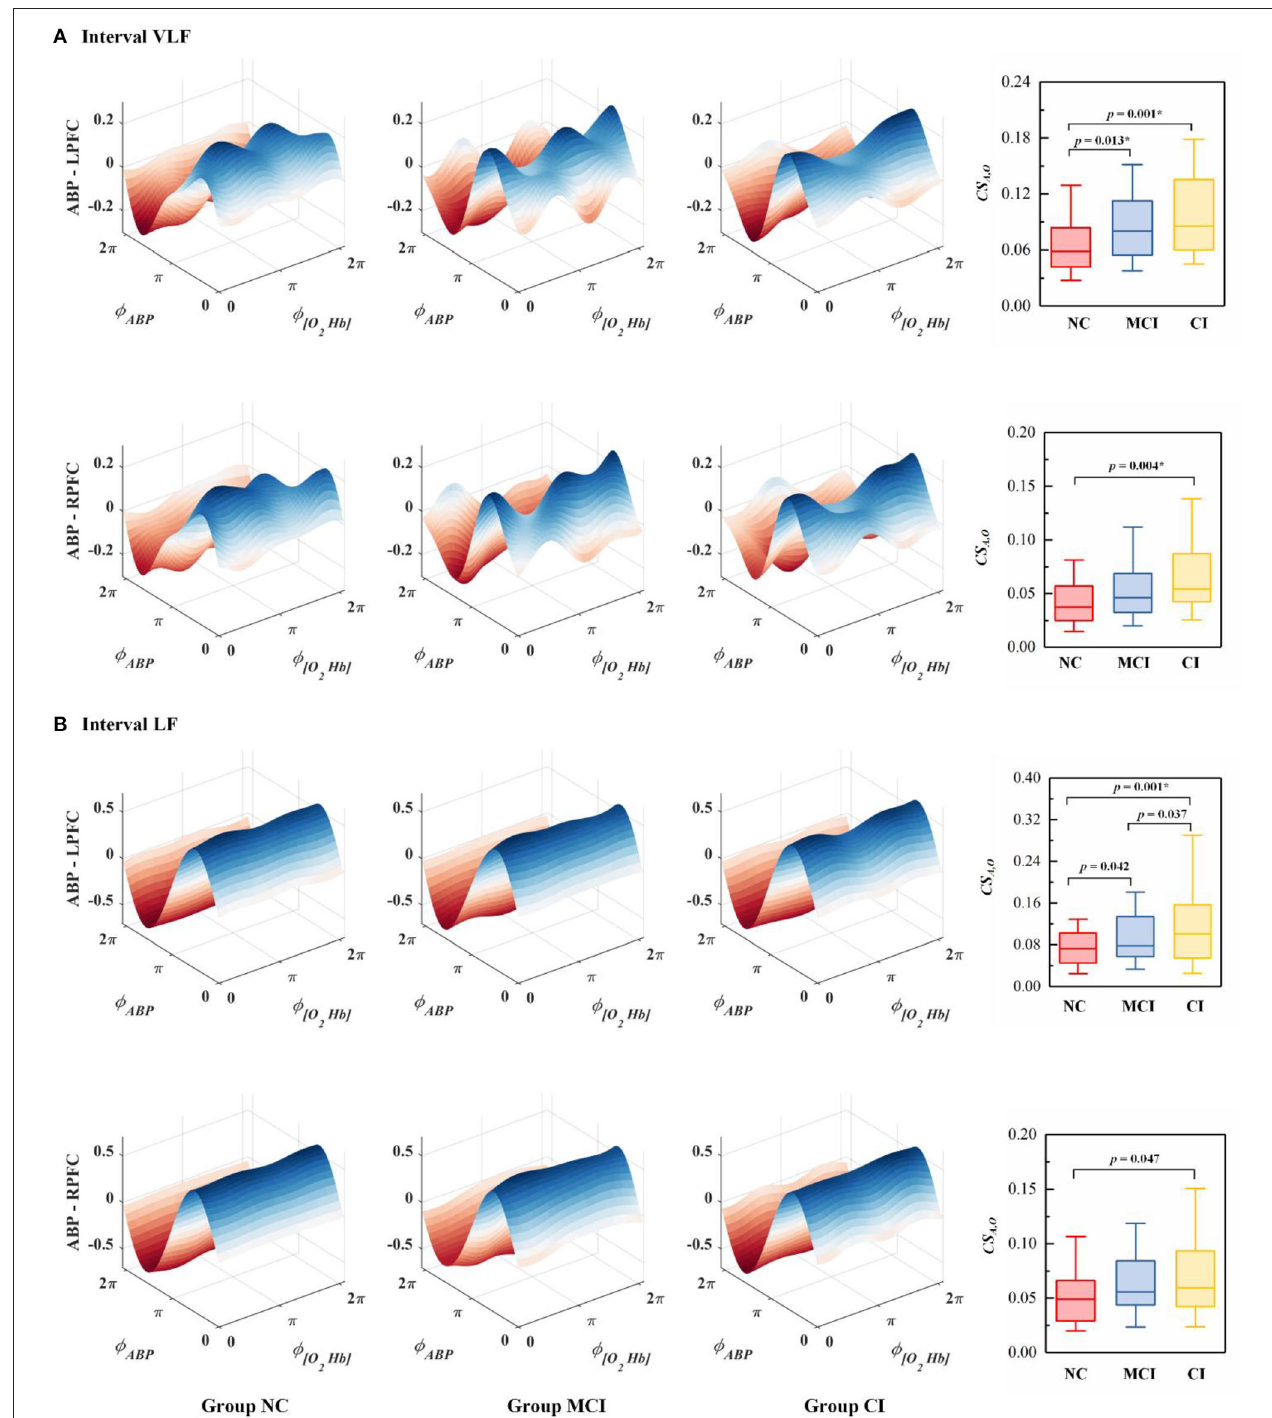
FIGURE 4 | The average coupling functions from all subjects within the group between ABP and 1 [O 2 Hb] in the (A) VLF interval and (B) LF interval. The coupling between ABP and 1 [O 2 Hb] in the bilateral PFC is denoted as ABP - LPFC and ABP - RPFC. φ ABP and φ [ O 2 Hb ] represent the dynamical phase information of ABP and 1 [O 2 Hb] signal, respectively. Each boxplot shows the coupling strength distribution of a specific coupling relationship in the resting state indicated by the NC (Group NC), MCI (Group MCI), or CI (Group CI). The NC group is indicated by red rectangles, the MCI group by blue rectangles, and the CI group by yellow rectangles. The line connectors on the tops of individual panels indicate cases where the difference between two boxplot distributions was statistically significant. p < 0.0167 are marked with *.